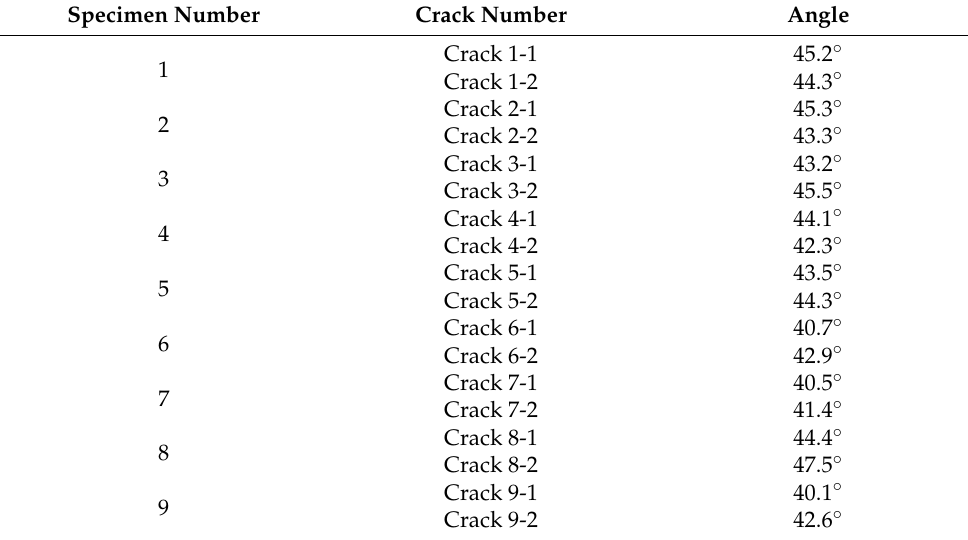
Table 5. Angle between crack propagation path and x -axis in the cruciform specimen. Specimen